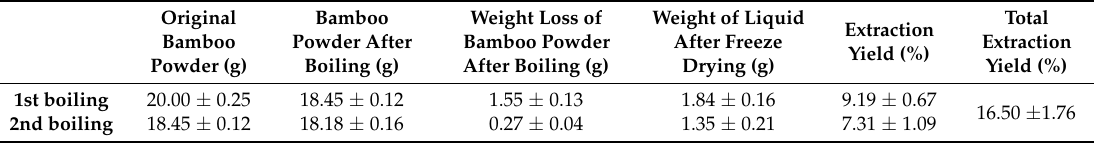
Table 2. The weight changes of the bamboo powder after boiling with a buffer (all the data presented results from the mean of 3 independent